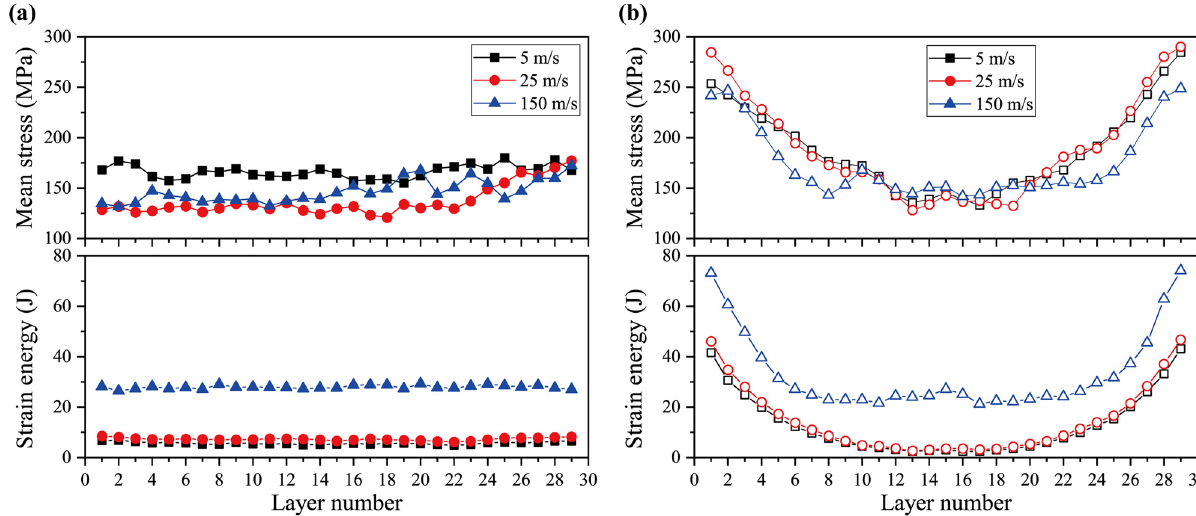
Figure 8: Curves of the average Mises stress and total strain energy versus grid layers. Gradient coe ffi cient a = ( a ) 0, and ( b ) − 0.6. Nominal strain ε =